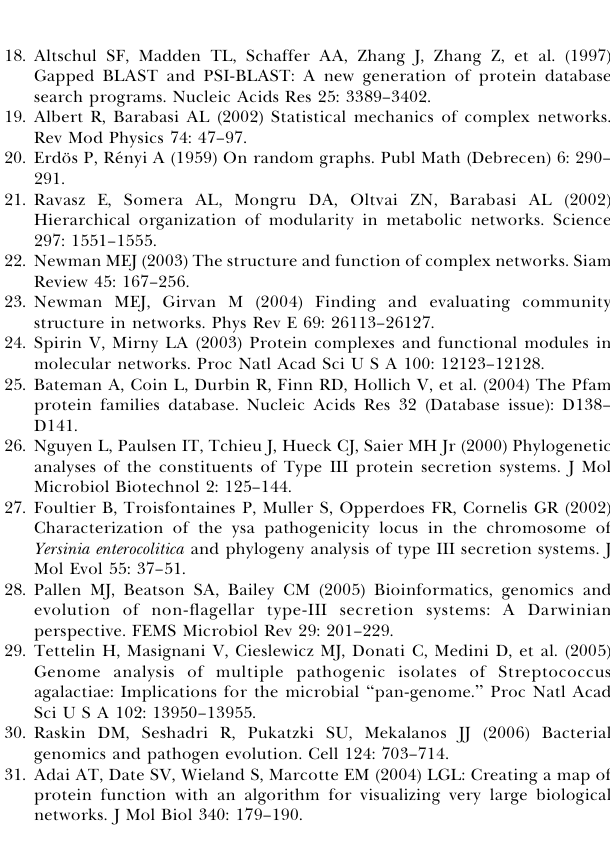
Table S1. T3SS and T4SS Reference Dataset